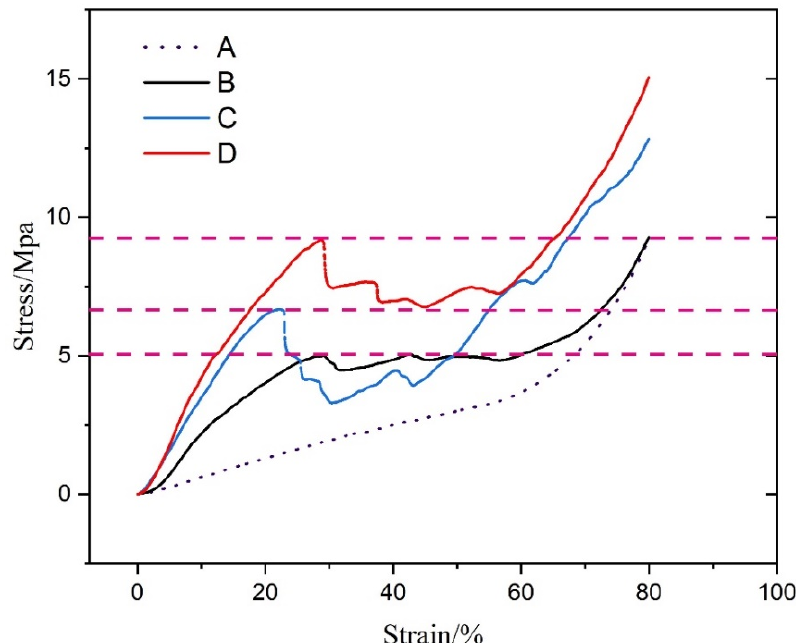
Figure 5. Pressure resistance analysis of (A) group A microcapsules; (B) group B microcapsules; (C) group C microcapsules; and (D) group D microcapsules.